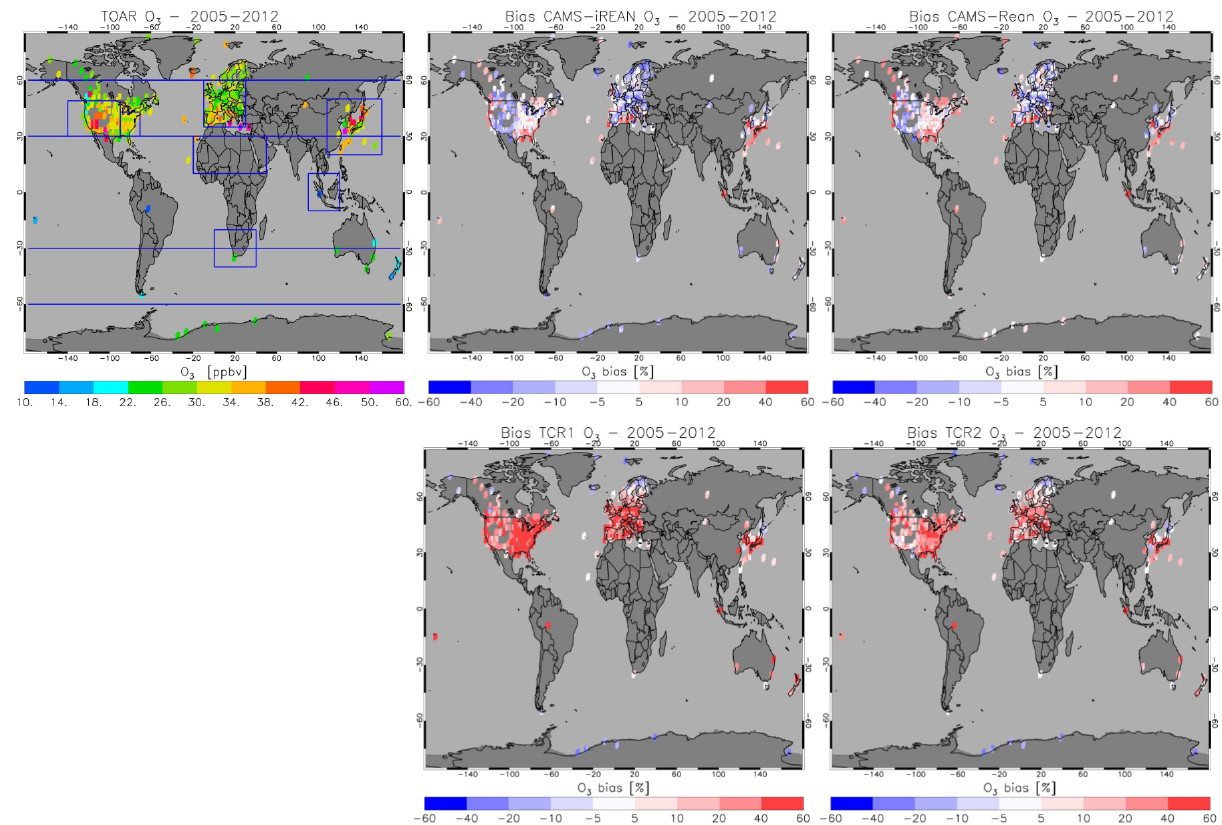
Figure 7. Multiannual (2005–2012) mean surface ozone from TOAR (upper left), along with corresponding normalized mean bias with respect to the observations for the